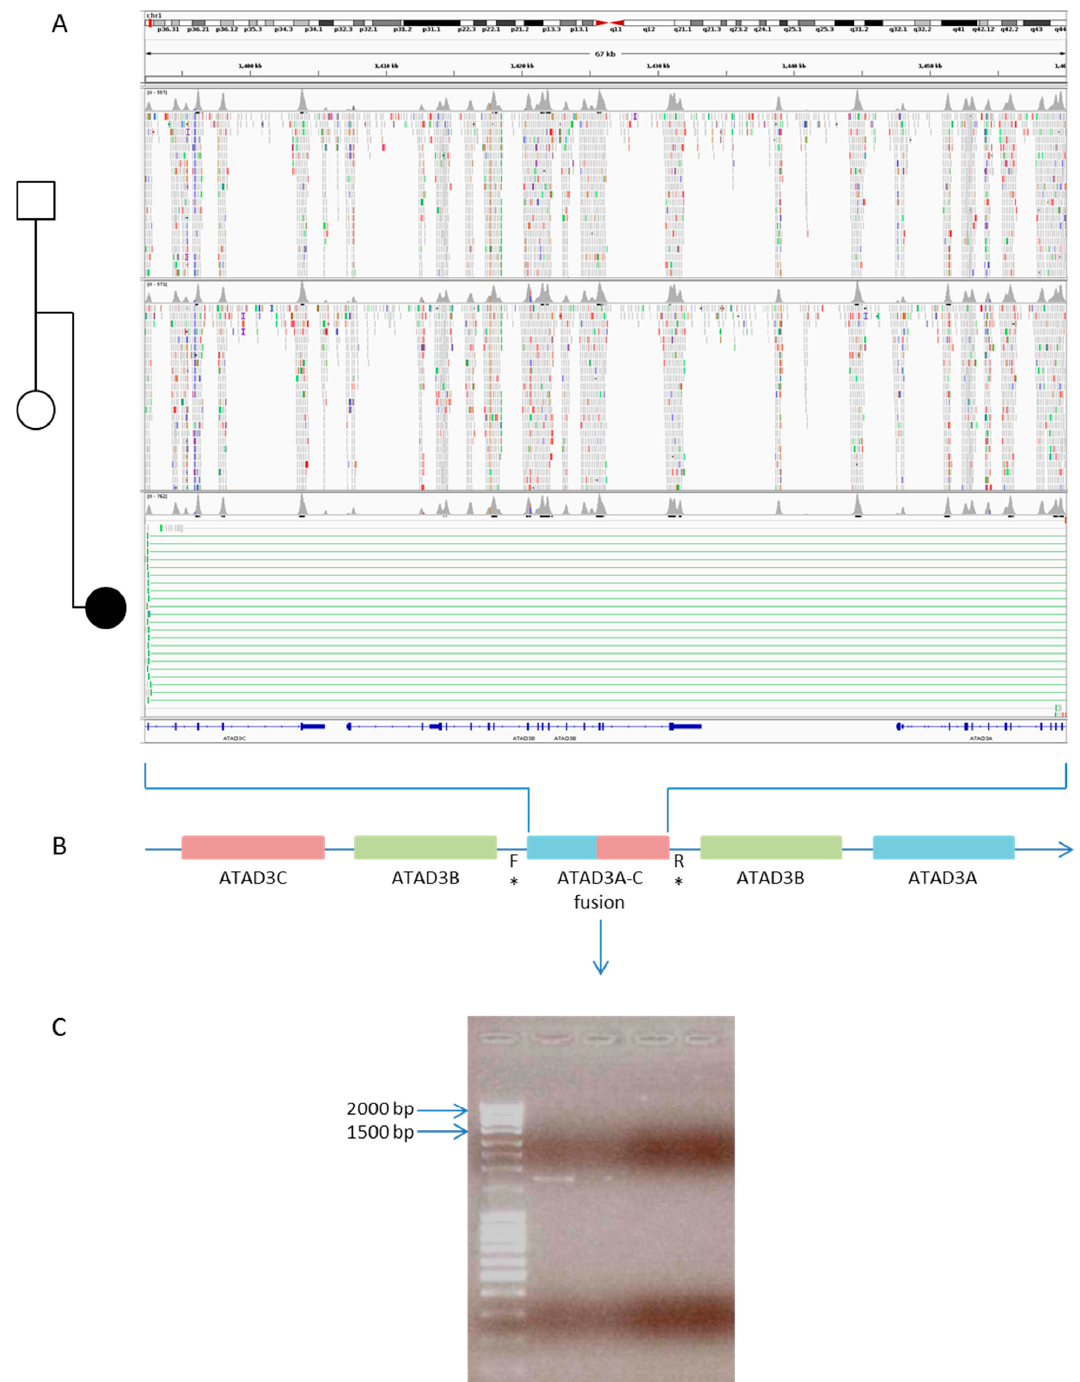
Figure 4. De novo duplication of the ATAD3 gene cluster (OMIM #618815) identified in a female newborn with left ventricle hypertrophy and clinical suspicion of mitochondrial disease. ( A ) In a newborn female presenting with brain anomalies, left ventricular hypertrophy and corneal opacity, leading to the clinical suspicion of mitochondrial disease, we identified a previously reported de novo duplication in the ATAD3 gene cluster (chr1:1392270_1460317dup), which creates an ATAD3A-C fusion gene ( B ). The presence of the duplication has been confirmed by PCR ( C ) using the same primers reported by Gunning et al. [25] for case 4 (* F: chr1 (GRCh37):1459103-1459123 and * R: chr1